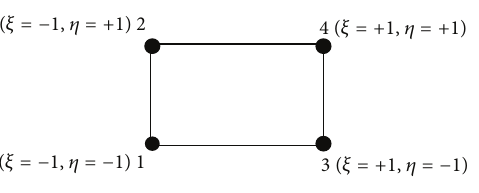
Figure 4: Shape function of isoparametric four nodes.